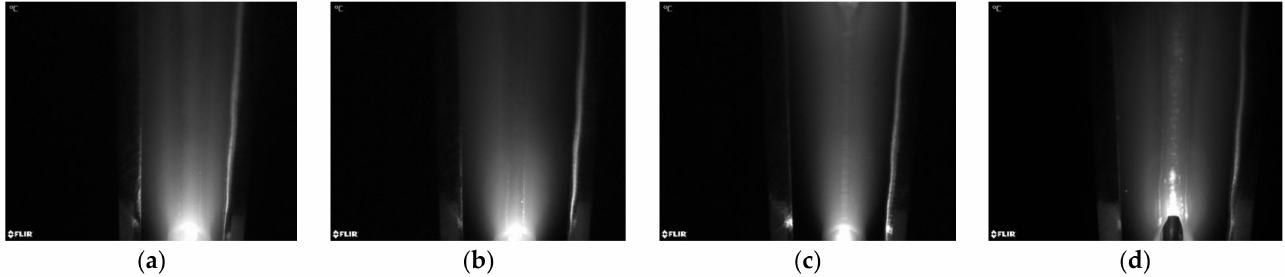
Figure 8. Sample IR images of weld face sides: ( a ) sample S13, ( b ) sample S15, ( c ) sample S19, and ( d ) sample